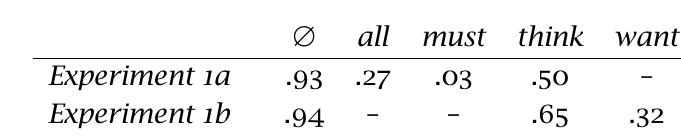
Table 2 : Rates of positive responses observed in Experiments 1